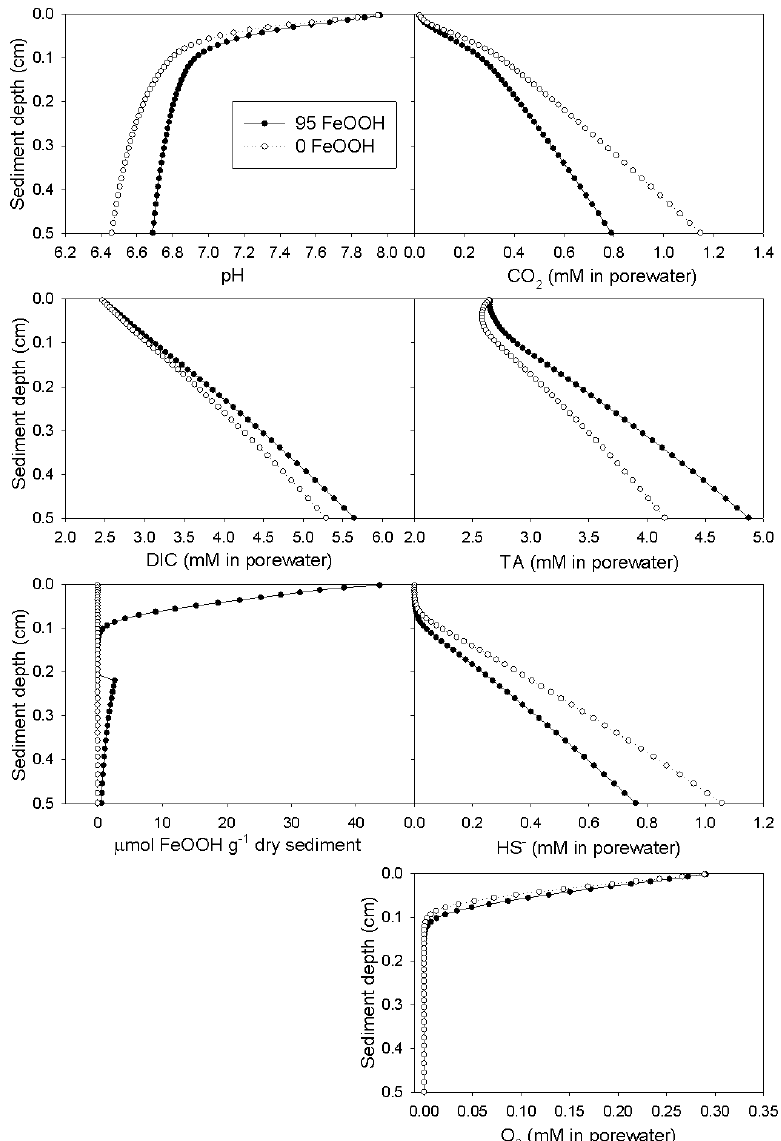
Fig. 7. Profiles of pH, CO 2 , DIC, TA, FeOOH and HS − and O 2 from two simulations. Empty circles represent a simulation with no FeOOH, whereas filled circles represent 95µmolg − 1 sediment ( d/w )